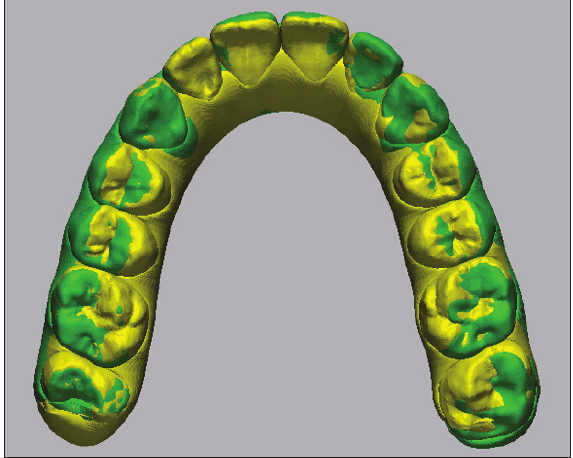
Figure 3. Direct visual comparison. Green = reference (predicted) model, Yellow = measured (achieved)